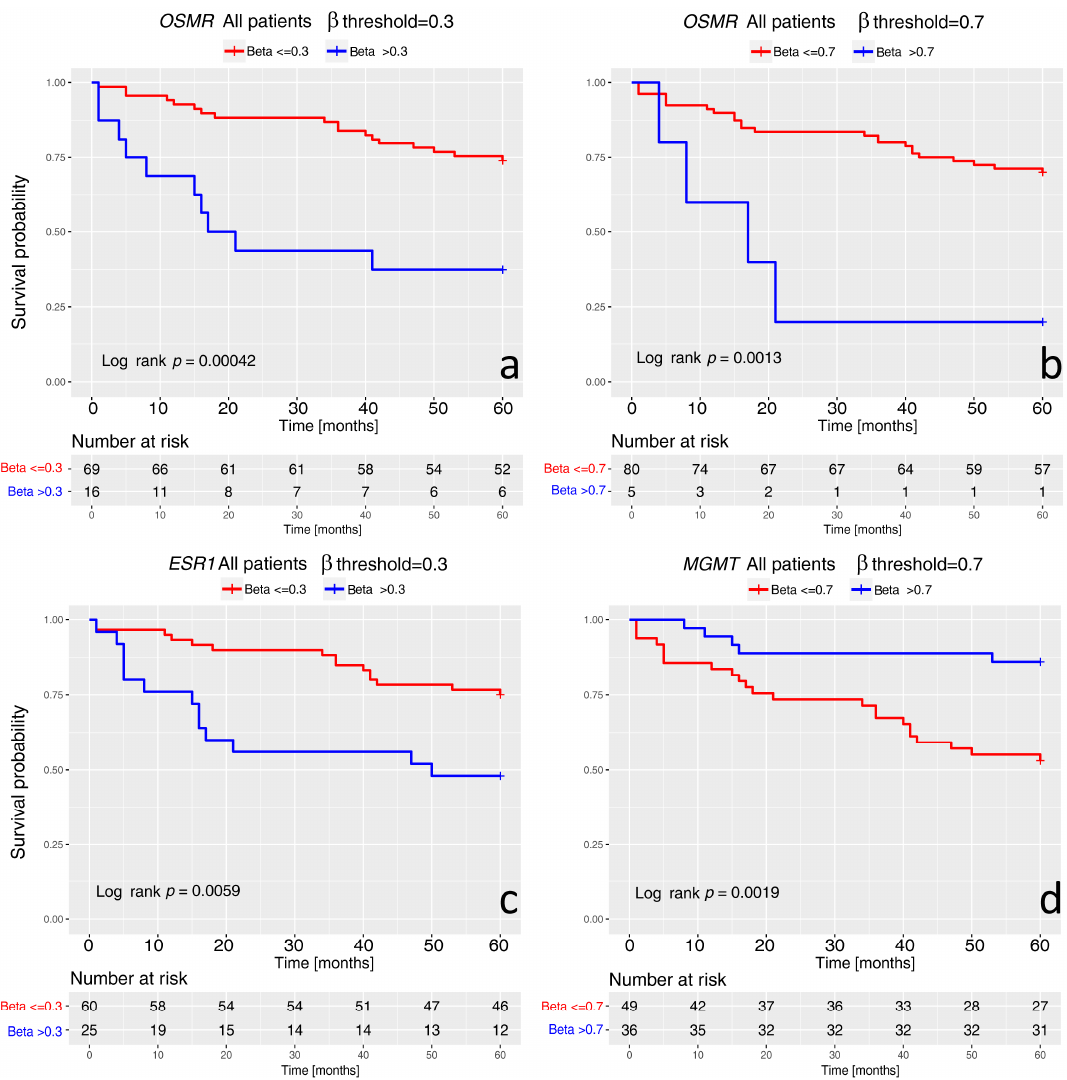
Figure 3. Kaplan-Meier analysis of overall survival of epithelial ovarian cancer patients. The analysis was carried out through the function “survfit” of the R package “survival” (ver. 2.42-3, Available online: https://cran.r-project.org/web/packages/survival/index.html) with the log-log mode setting. Each graph legend reports the β threshold and their colors (red, blue) and the p value of the test for the significant difference between the curves. Curves for OSMR gene were generated with two threshold levels of β methylation, 0.3 and 0.7 ( a , b ), respectively. Curves for ESR1 gene were generated with threshold 0.3 ( c ). The curves for MGMT gene were generated with threshold of 0.7 ( d ). The number of patients in each subgroup is reported in the table at the bottom of each graph. The censored cases are marked by “+”.